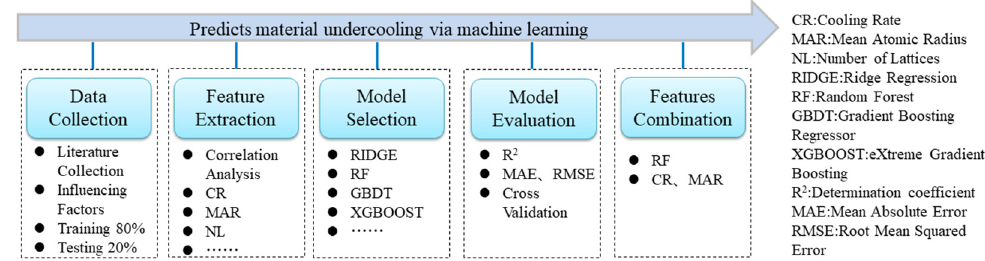
Figure 1. Strategy and machine learning (ML) model workflow for a given material ML prediction model.